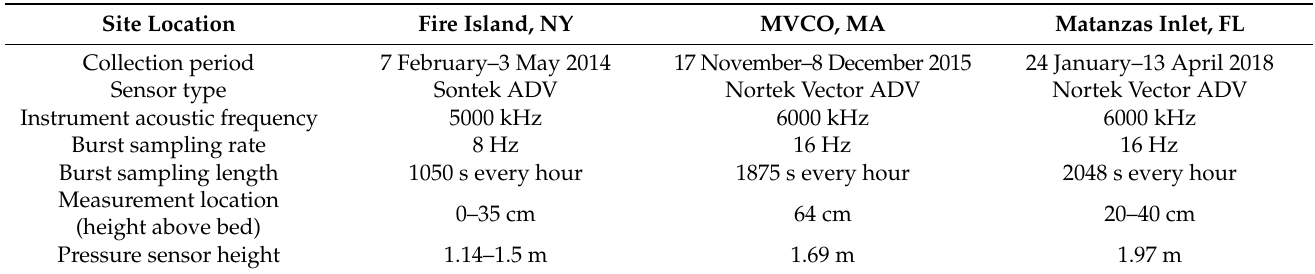
Table 3. ADV sensor specifications for the three sites. The sensor height for the velocity measurements changed during the deployment period (distance to the measurement